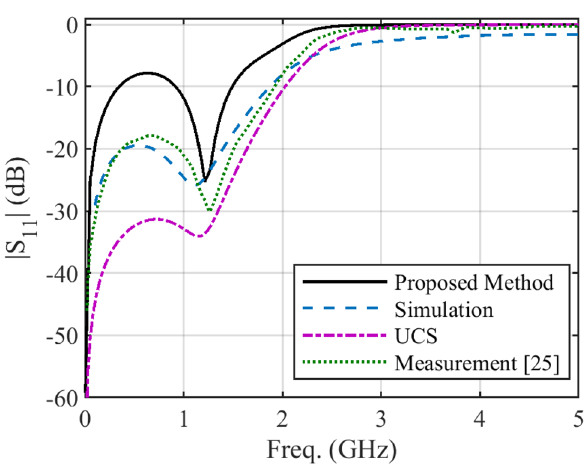
Figure 7. Magnitude of S 11 of the stepped-impedance filter.